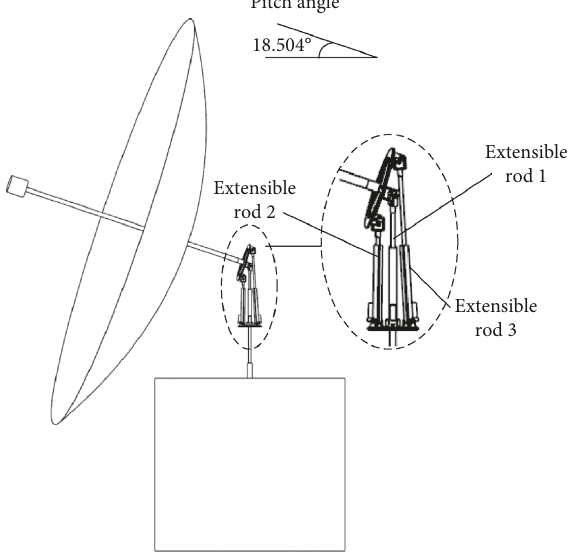
Figure 24: Simulation model of the sun tracking process.